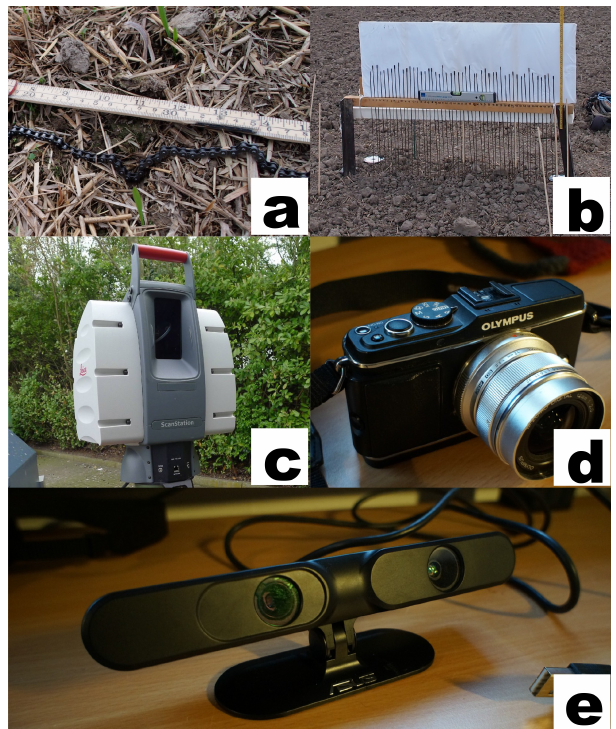
Figure 3. Five devices used for measuring soil surface roughness: (a) roller chain, (b) pinboard, (c) Leica terrestrial laser scanner, (d) the digital camera used for creating stereophotos, and (e) the Xtion Pro. Images (a) and (b) show contact methods, while (c) , (d) and (e) show non-contact